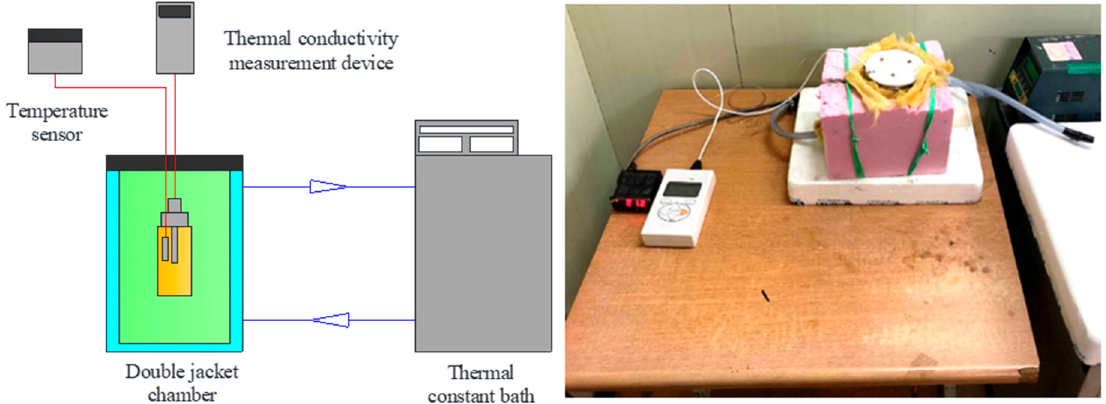
Figure 3. Schematics and picture of thermal conductivity experimental setup. Table 3. Physical properties of water / ethylene glycol (20 vol%) as a base fluid [32]. Temperature ( ◦